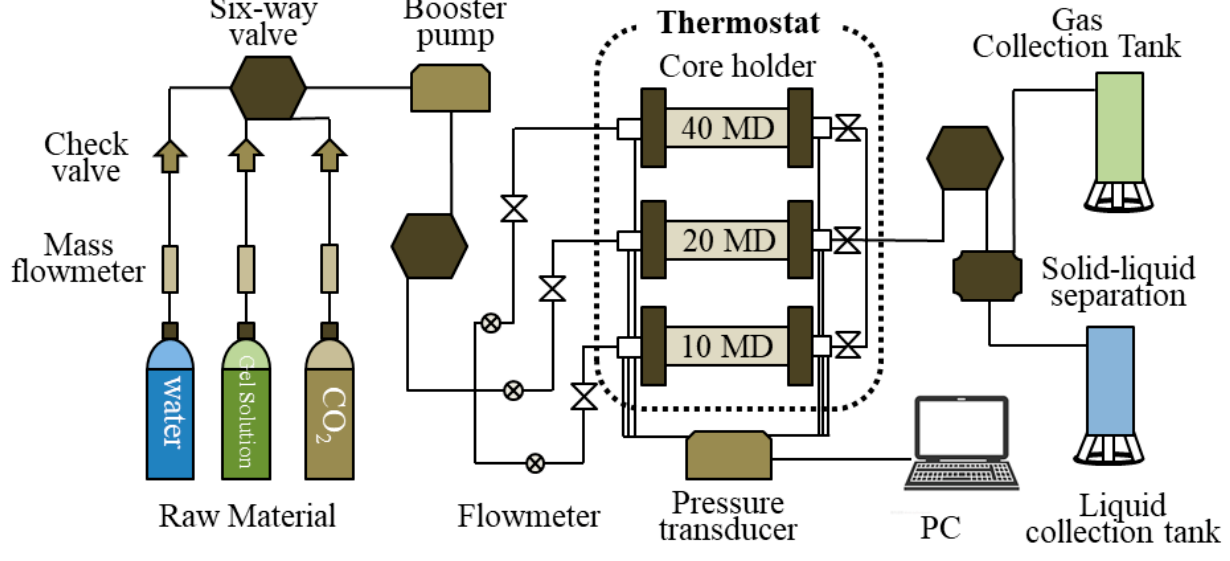
Figure 7. Schematic diagram of the plugging device.